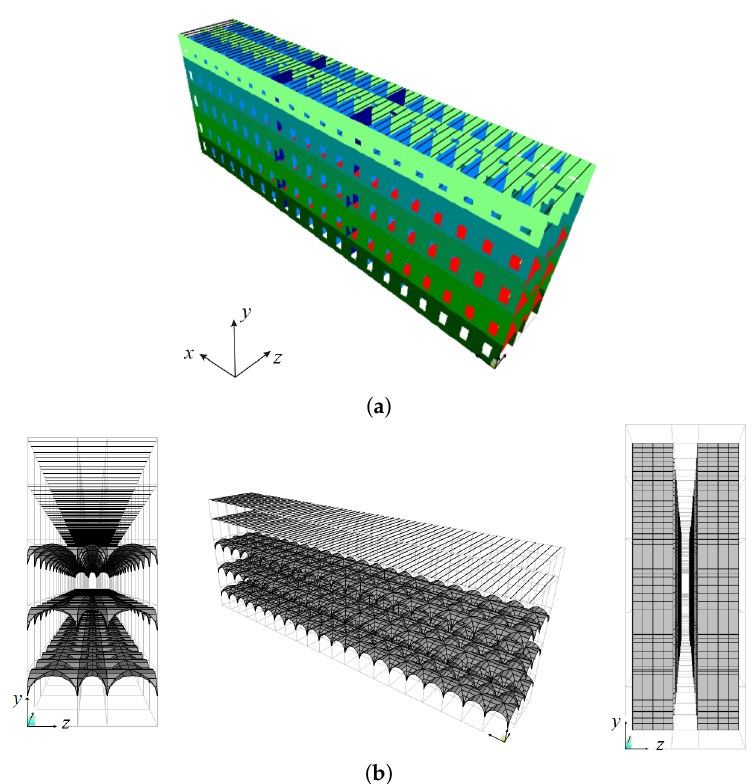
Figure 3. Fine finite element model: ( a ) overview; ( b ) details of slabs and transverse